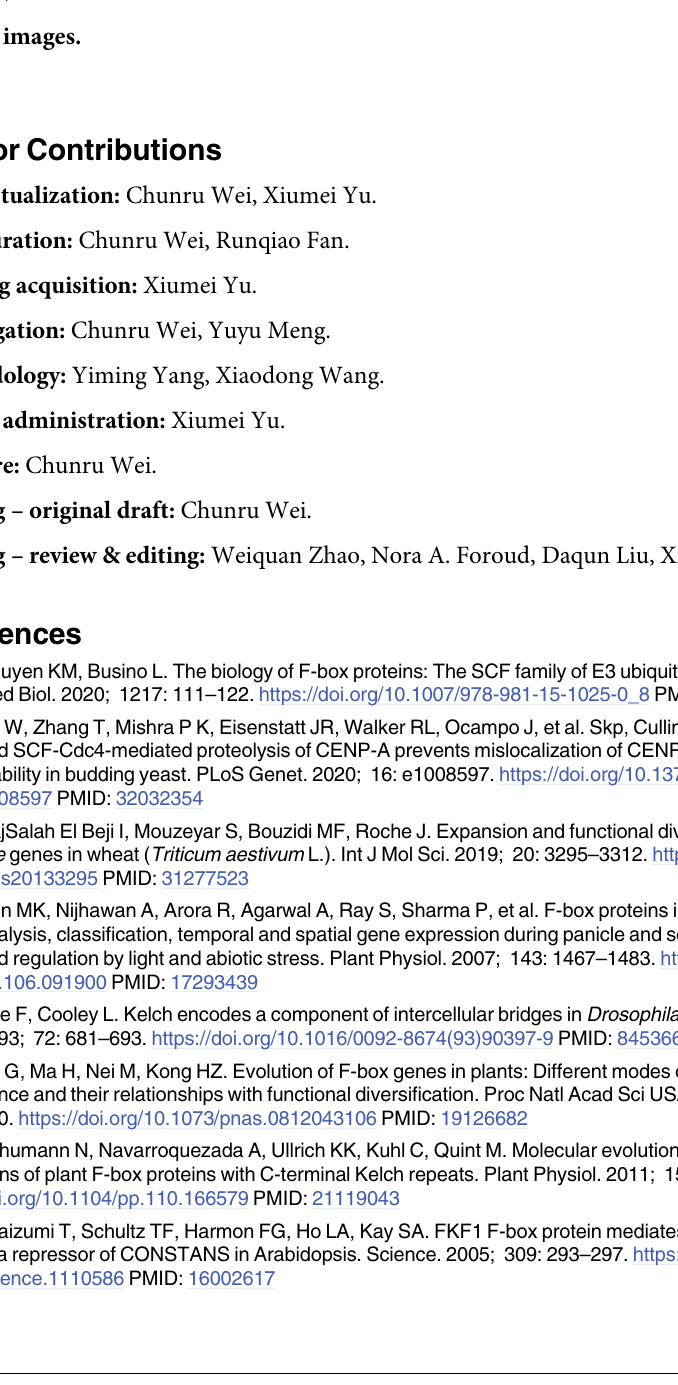
S3 Table. FPKM values of wheat FBK genes. S4 Table. Screening of the candidate proteins interacting with TaAFR. S5 Table. Bioinformatics analysis of the candidate